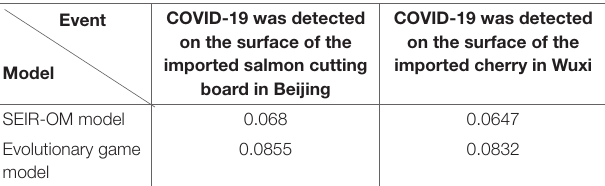
TABLE 7 | RMSE of network